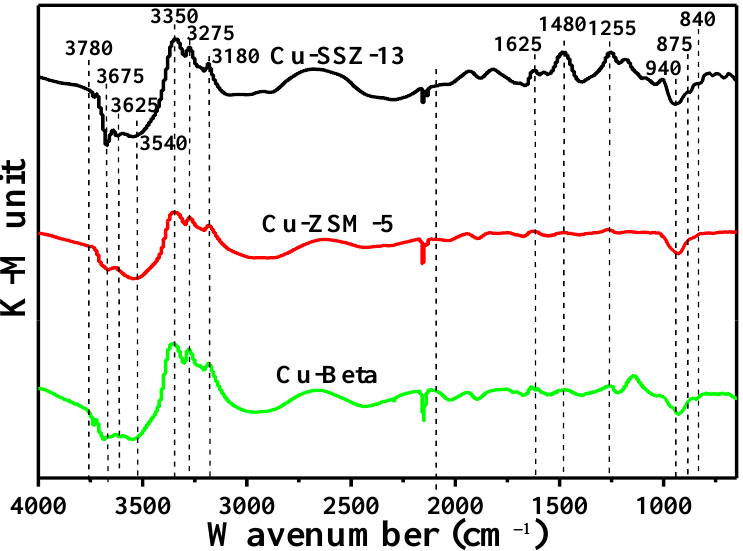
Figure 9. DRIFTS Spectra of NH 3 adsorption on the copper-based zeolites (Prior to NH 3 adsorption, each catalyst was oxidized at 500 °C for 60 min).